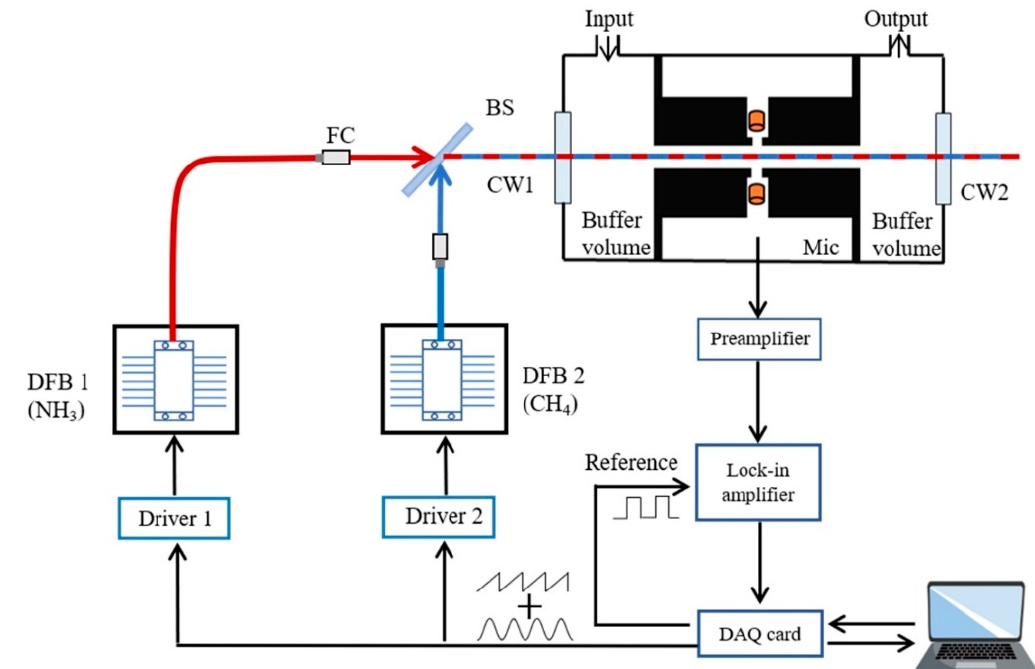
Figure 1. Schematic of the PA instrument. FC: fiber collimator. BS: beam splitter. CW1, CW2: CaF 2 window. DFB: distributed feedback laser diode. Mic: electret microphone. DAQ card: data acquisition card.